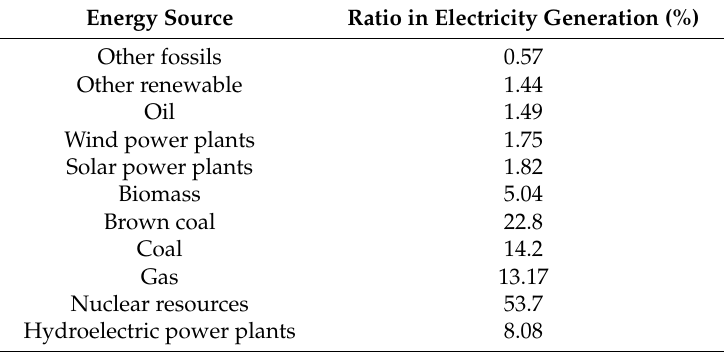
Table 3. Energy mix in Slovakia [4].